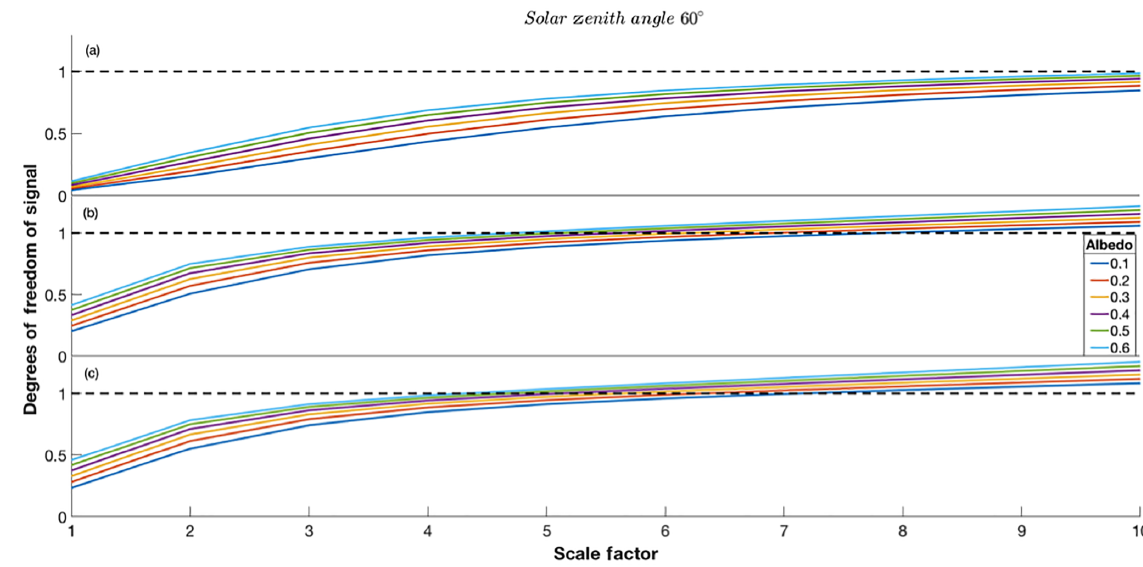
Figure A1. Degrees of freedom for 13 CH 4 vs. scaling factor f for scenarios outlined in Table 3. Each coloured line represents different surface albedo conditions as shown in the key. The black dashed line represents unity DOFS: panel (a) indicates scenario 2, panel (b) indicates scenario 5 and panel (c) indicates scenario 8.